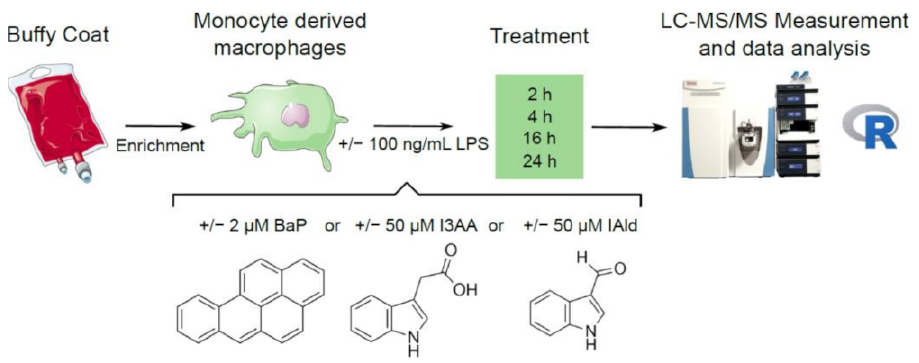
Figure 1. Experimental design. PBMCs were isolated from Buffy Coats and monocytes enriched.